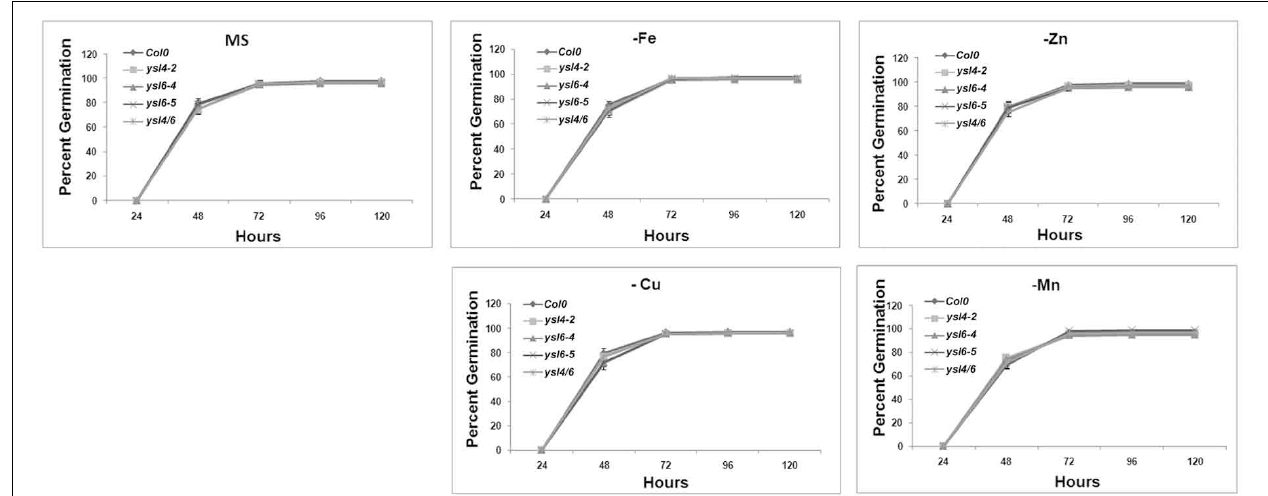
FIGURE 7 | Germination response to metal deficiency. Seeds of ysl6-4, ysl6-5, ysl4-2 or the ysl4ysl6 double mutant were germinated on complete MS medium or MS medium lacking Fe, Zn, Cu, or Mn.